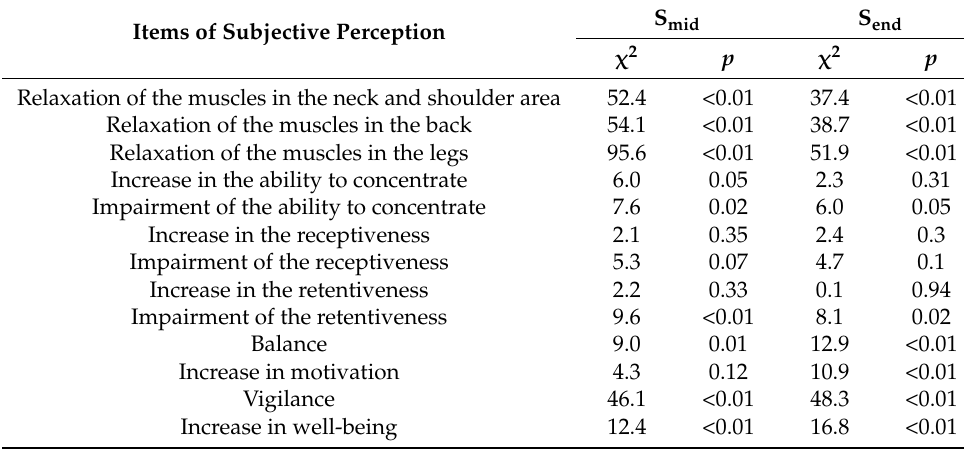
Table 6. Results of the Kruskal–Wallis test at S mid (N = 631) and S end (N = 526).